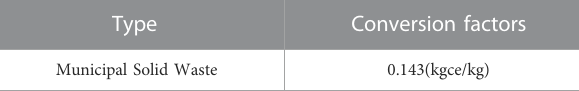
TABLE 6 Coal equivalent conversion factors of municipal solid